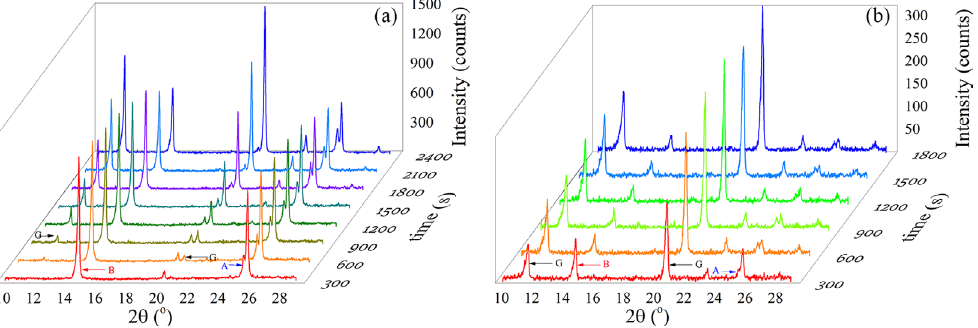
Figure 11. In-situ XRPD patterns of the hydration of samples (a) CP2 and (b) RP2. We highlight the main peaks of the anhydrite (A) bassanite (B) and gypsum (G) phases.